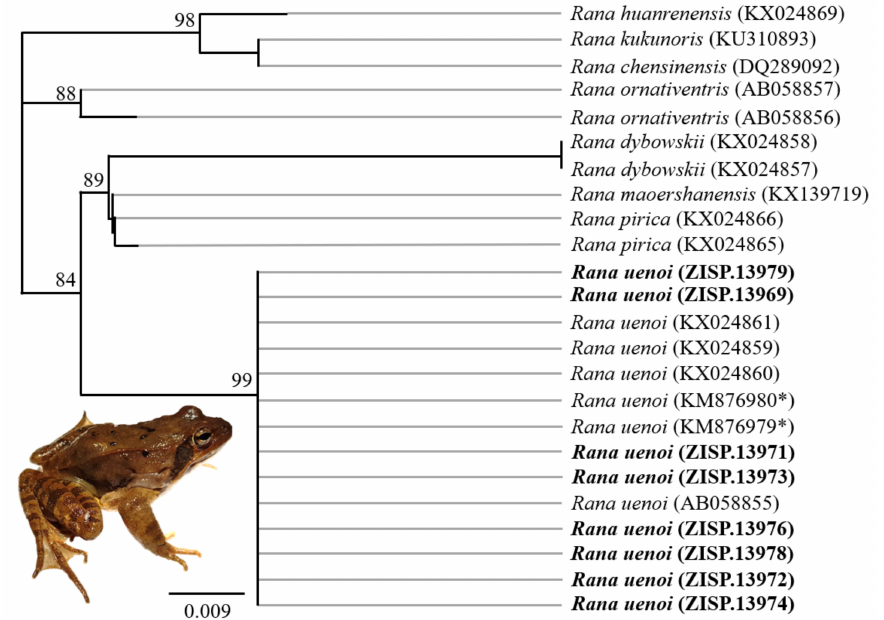
Figure 4. Simplified maximum likelihood phylogenetic tree built with the PHYML plugin in Geneious for Rana sp. samples. The results clarify the presence of R. uenoi in the vicinity of Pyongyang, DPR Korea (GenBank accession numbers shown in Table 2). Branch distances represent nucleotide substitution rates and the scale bar represents the number of changes per nucleotide position. The species identification for individual Rana dybowskii from R Korea was arbitrarily reassigned to R. uenoi based on the study by Matsui (2014). These individuals are indicated by *. Samples originating from this study are shown in bold.